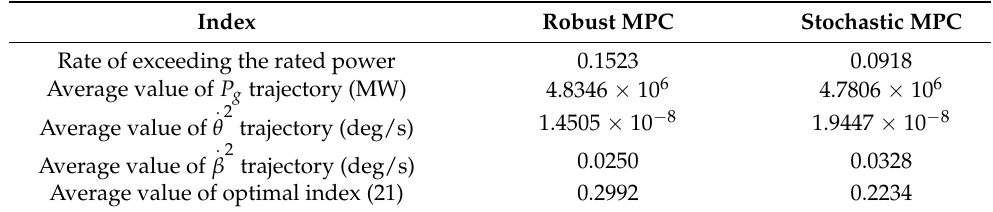
Table 3. Comparing results between robust MPC and stochastic MPC in the high wind speed region with slight turbulence.